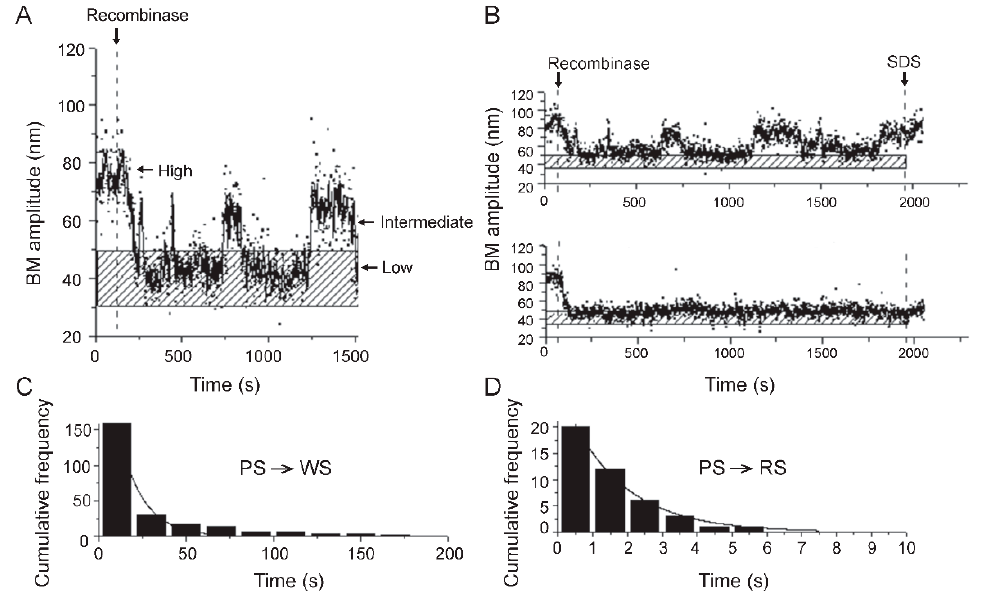
Figure 6. Thermodynamic and kinetic information conveyed by TPM. ( A ) A typical time trace shown here illustrates the BM amplitude changes in a DNA substrate containing a pair of recombination target sites (in head-to-tail orientation) from ‘high’ to ‘intermediate high’ following recombinase occupancy of the sites, and to ‘low’ upon synapsis of the bound sites. ( B ) The top trace is representative of a molecule (with head-to-tail target sites) that bound recombinase, and went through synapsis and synapse dissociation several times without completing recombination (as shown by its return to the high amplitude state after SDS treatment). The bottom trace exemplifies a molecule that completed binding, synapsis, and Holliday junction formation or DNA excision successfully (as signified by the low BM amplitude after SDS treatment). In A and B, the stippled horizontal bar denotes the BM amplitude of the synapsed state. ( C , D ) From the dwell times of DNA molecules in the unbound state or as distinct recombinase-bound complexes, kinetic features of the individual steps of recombination can be derived. The histogram plots for the pre-synaptic state (PS) before conversion to wayward synaptic complexes (WS; which are abortive and dissociate), fitted to a single exponential algorithm ( C ), yields a first-order rate constant of (7.2 ± 0.8) × 10 − 2 s − 1 for this step (PS → WS). From a similar analysis of the transition from pre-synaptic to recombination-competent synaptic complexes (RS; those that promote strand exchange) ( D ), the first-order rate constant is (6.3 ± 0.4) × 10 − 1 s − 1 (PS → RS). ( A , B ) show results from our studies of Flp, a tyrosine recombinase. ( C , D ) depict the behavior of φ C31 integrase (a serine recombinase) in our TPM experiments.